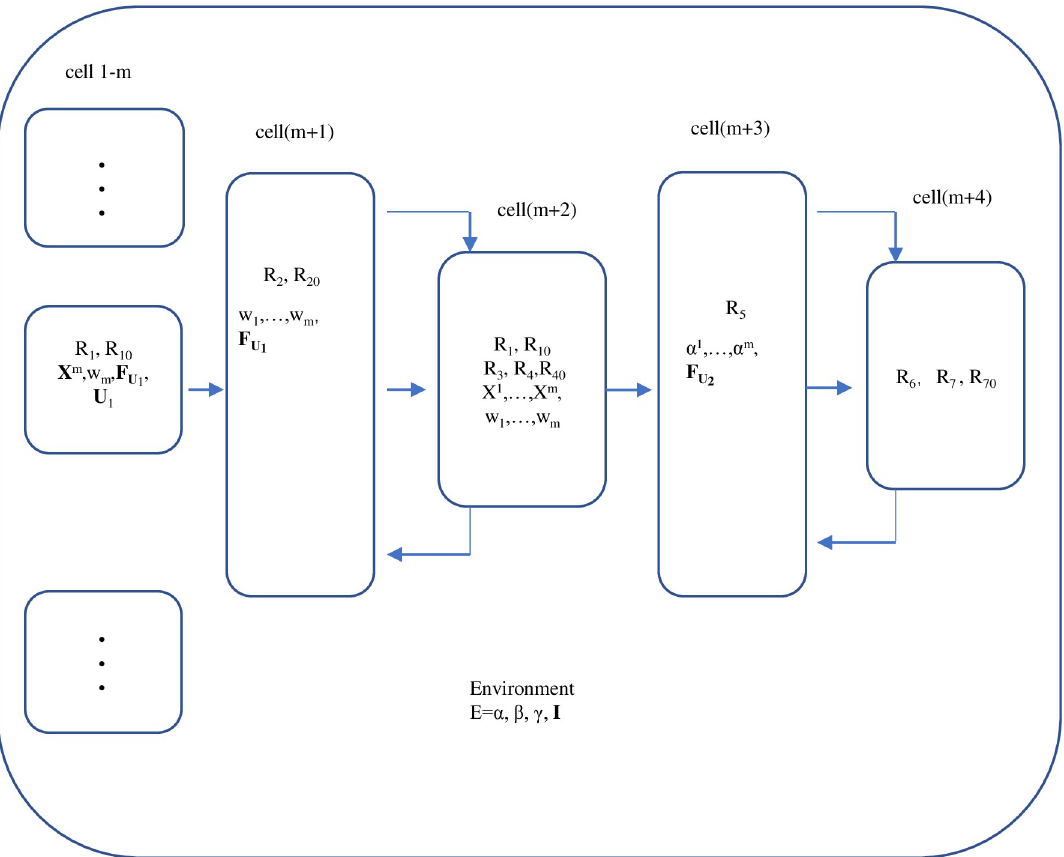
Fig 3. The initial configuration of the tissue-like P